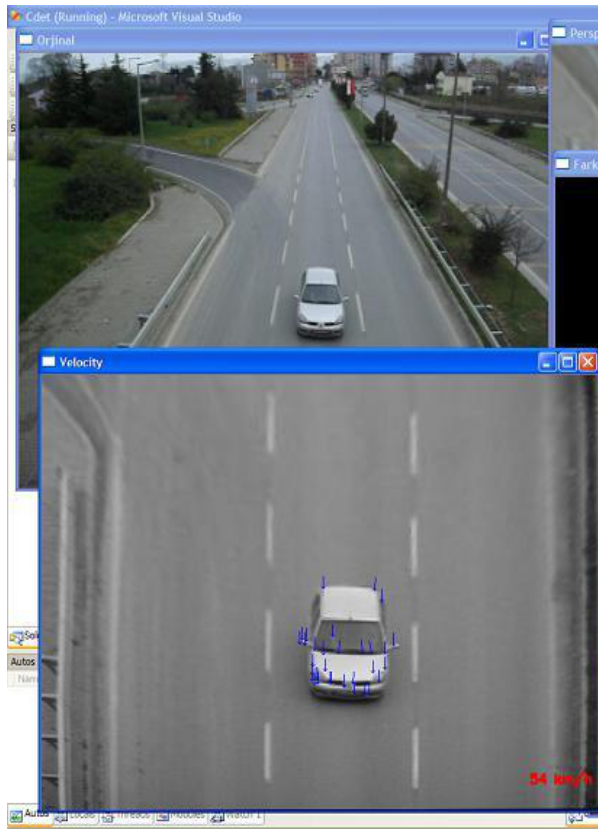
Figure 2. Estimation of